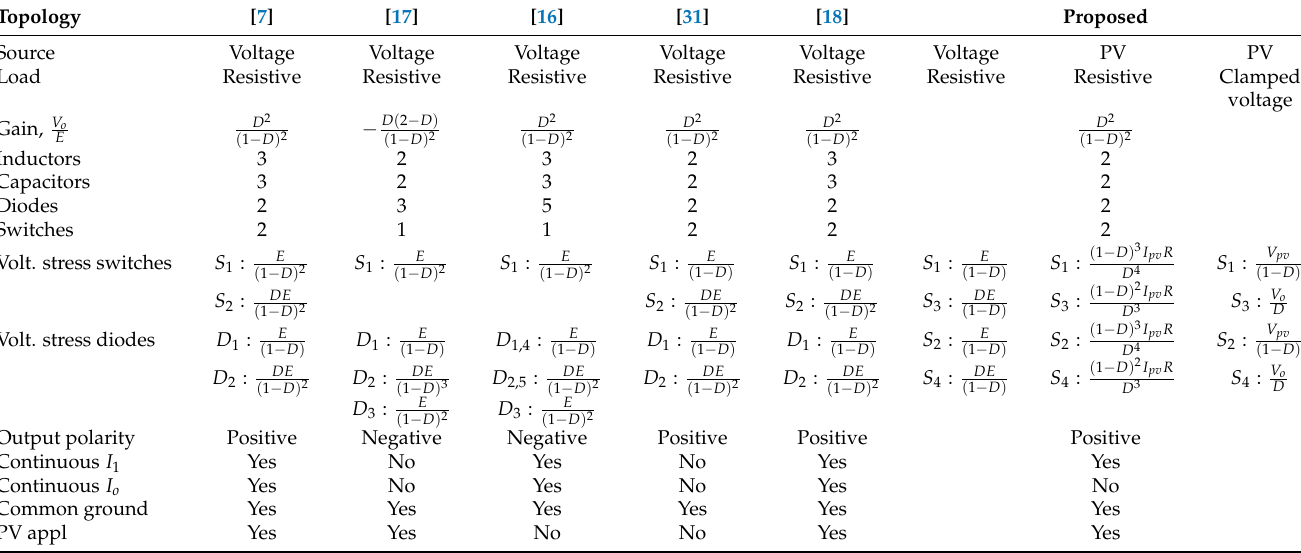
Table 2. Main characteristics of existing quadratic buck-boost